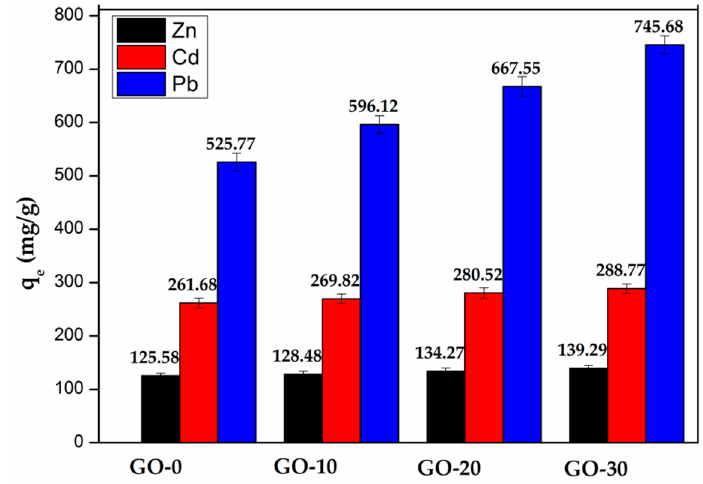
Figure 7. The influence of GO on the metal ions adsorption capacity of hydrogels.